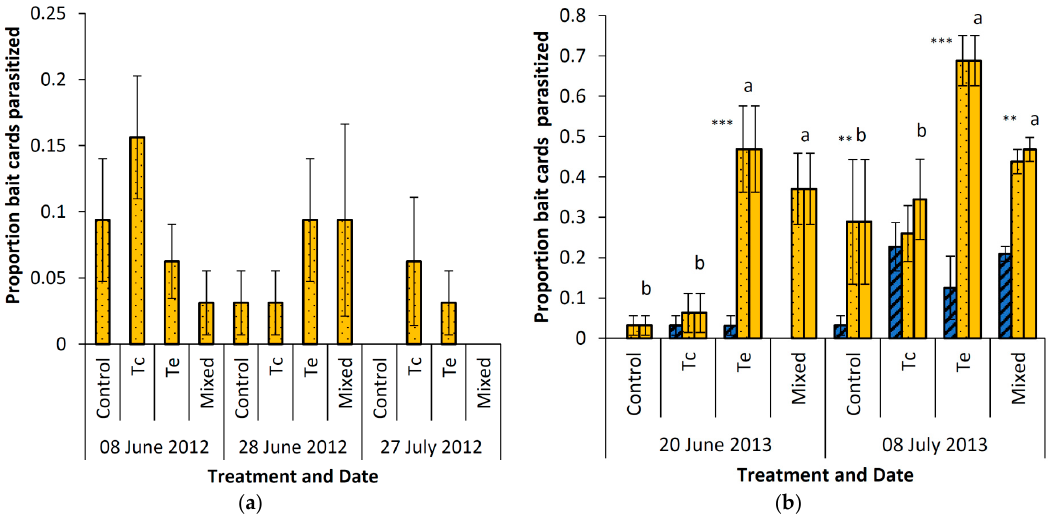
Figure 1. Trichogramma activity assessed as mean proportion (±SE) of bait cards being parasitized with Trichogramma evanescens (orange and dotted), T. cacoeciae (blue and hatched) and the total proportion bait cards being parasitized (purple) in a completely randomized block experiment with three treatments; mass release using Trichocards ® of T. evanescens (Te), T. cacoeciae (Tc), a mix of the two species (Mixed) and a control in ( a ) 2012, where only T. evanescens emerged and no significant differences were found between treatments, ( b ) in 2013 where both species emerged. Letters indicate significant differences between total proportion bait cards parasitized based on pairwise comparisons of ls-means. Asterisks indicate significant differences (Chi-square test, * p <0.05, ** p <0.01, *** p <0.001) between proportion cards found by the two species within a treatment. A laboratory check in 2013 of eight Trichocards, with T. cacoeciae , T. evanescens and a mix of the two species, showed that T. cacoeciae cards produced an average of 1737.5 ± 69.5 parasitoids of which 99.7% ± 4.0% were T. cacoeciae . For T. evanescens cards, 1475.0 ± 55.9 wasps hatched of which 100% ± 3.8% were T. evanescens . From the mixed Trichocards, 1975 ± 50.8 parasitoids hatched of which 54.6% ± 2.6% were T. evanescens (males and females) and 45.4% ± 2.6% T. cacoeciae (only females). Plots were as large as the orchard size permitted (20 m long and separated from other treatments, see details in Section 2.3), but in 2013, after the second augmentative release, the